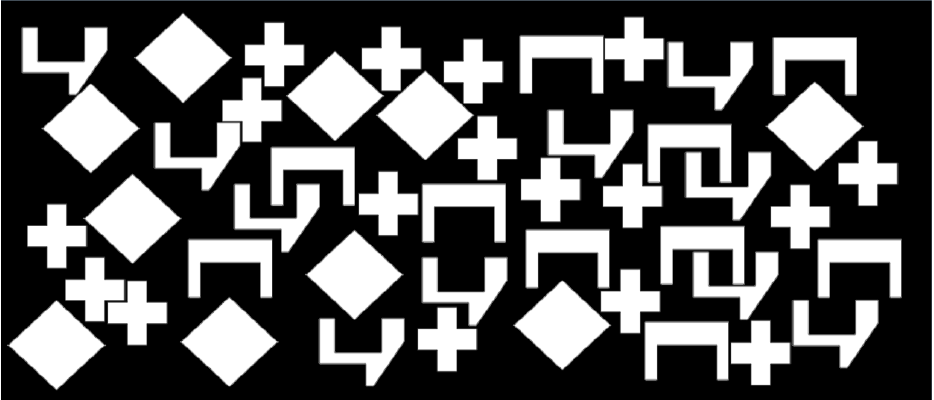
Figure 12. Solution found by the ILS algorithm inserting 49 pieces for the Shape 0 instance, consuming 2 h of processing time.